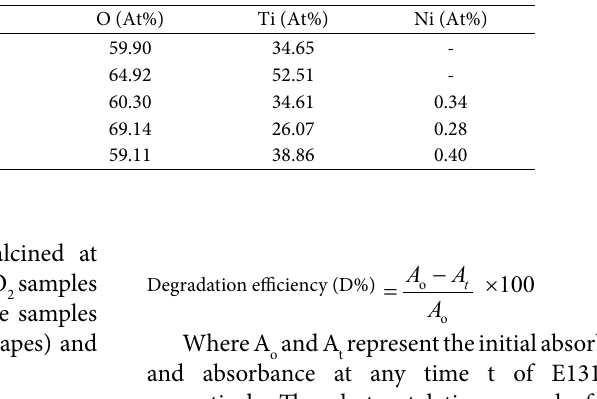
Table 5. EDX analysis of Ni-doped TiO